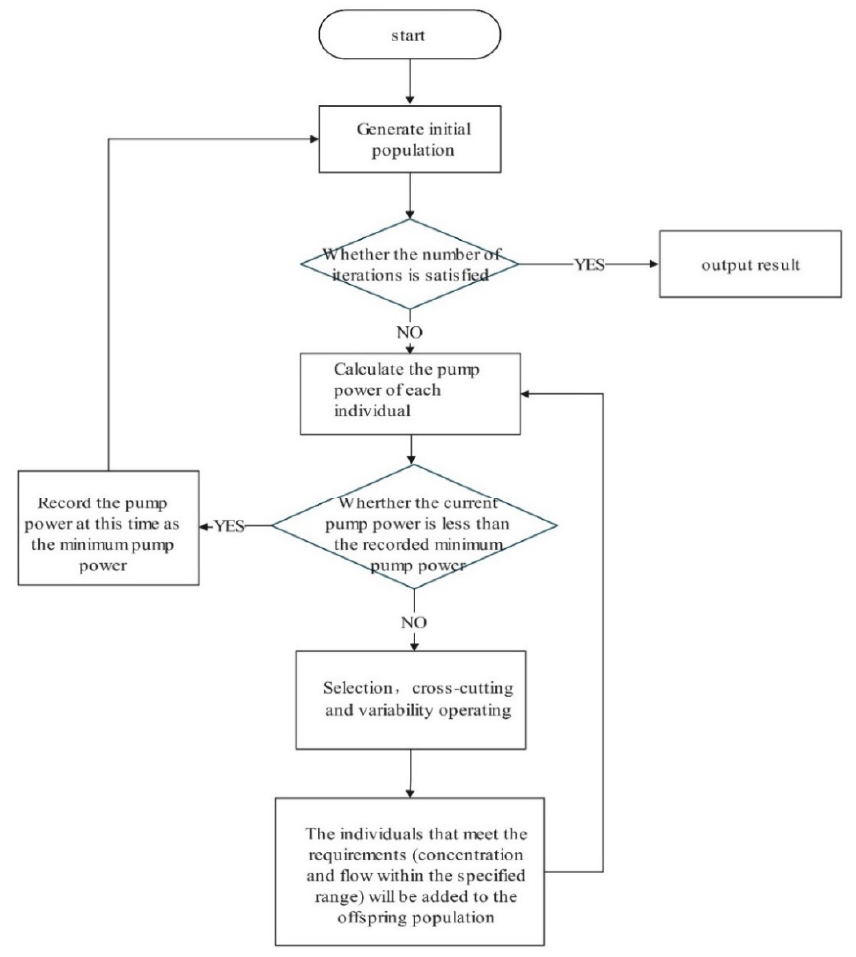
Figure 5. Algorithm flow